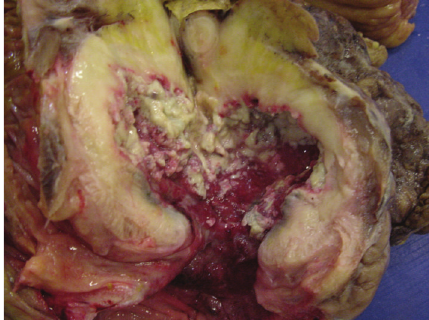
Figure 2: Macroscopic appearance of the specimen and sulfur granules in the